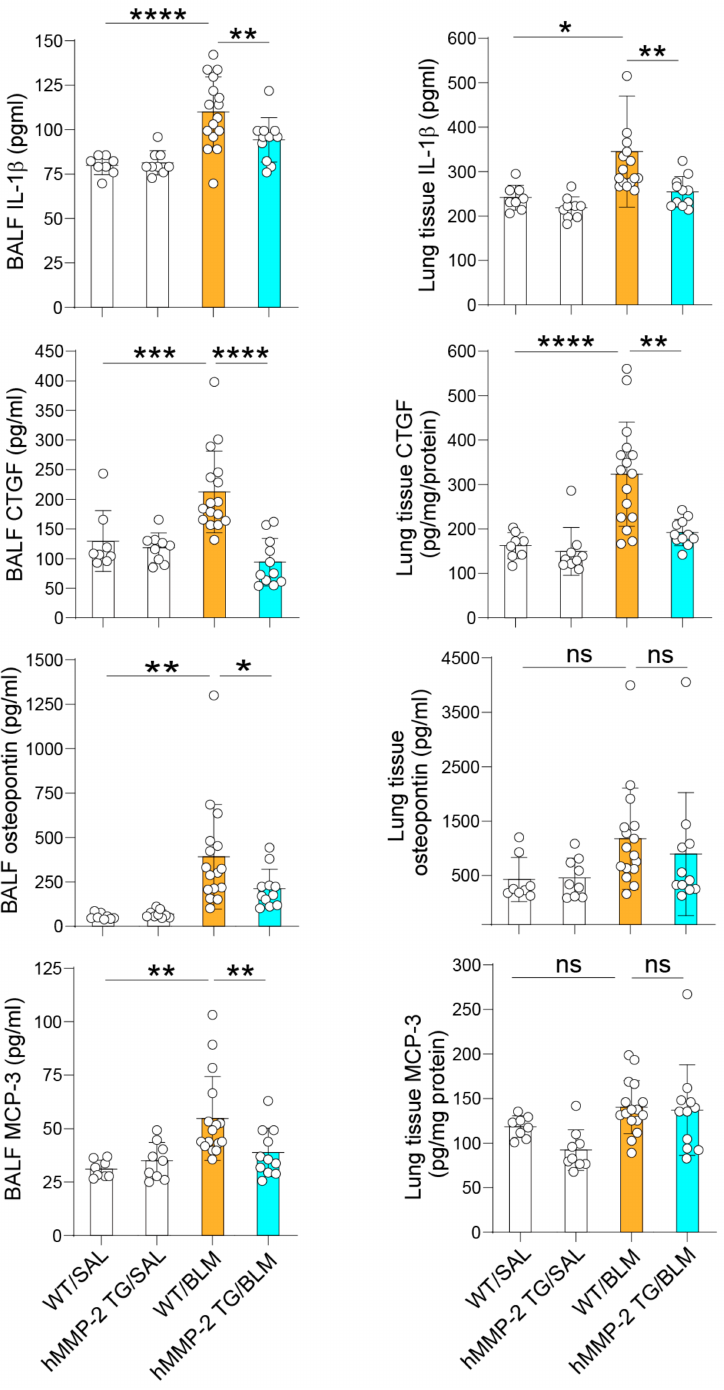
Figure 4. Substrates of hMMP-2 are reduced in the lungs of hMMP-2 TG mice. IL-1 β , osteopontin, MCP-3, and CTGF were measured by commercially available enzyme immunoassay kits following the manufacturer’s instructions. The number of mice: n = 8 in WT/SAL, n = 9 in hMMP-2 TG/SAL, n = 16 in WT/BLM, and n = 11 in hMMP-2 TG/BLM. Data are the mean ± S.D. All mice were female. Statistical analysis by ANOVA with Newman-Keuls test. **** p < 0.0001; *** p < 0.001; ** p < 0.01; * p < 0.05. WT, wild-type; hMMP-2, human matrix metalloproteinase-2; SAL, saline; BLM, bleomycin, MCP-3, monocyte chemoattractant protein-3; CTGF, connective tissue growth factor; ns, not